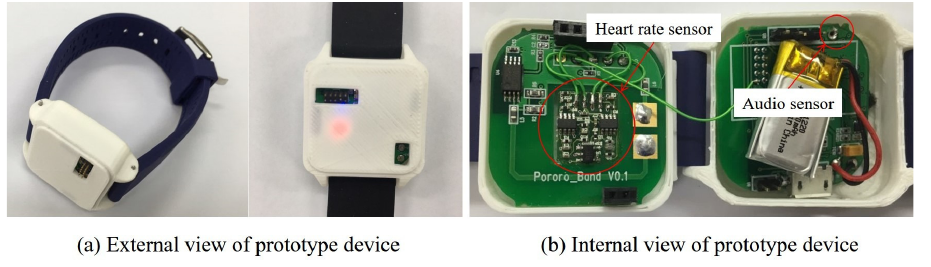
Figure 5. ( a ) External view and ( b ) internal view of the prototype of the wearable device, where the audio signal and heart rate of a child are